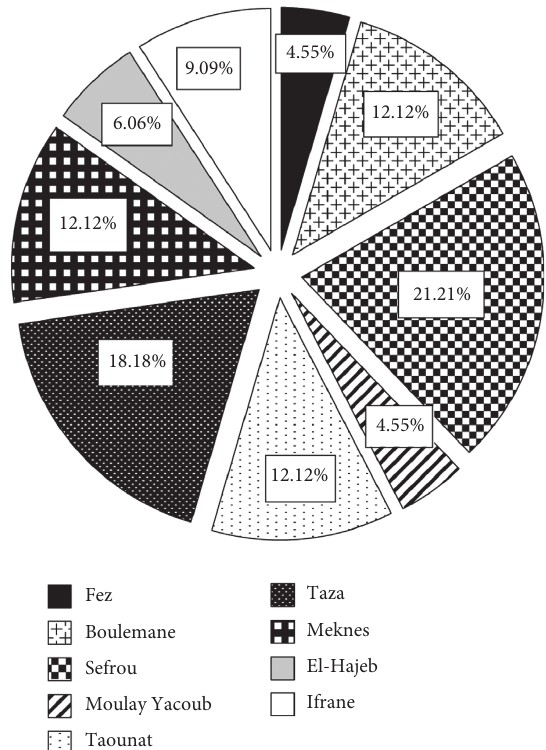
Figure 3: Distribution of beehive installation locations in the Fez- Meknes region.